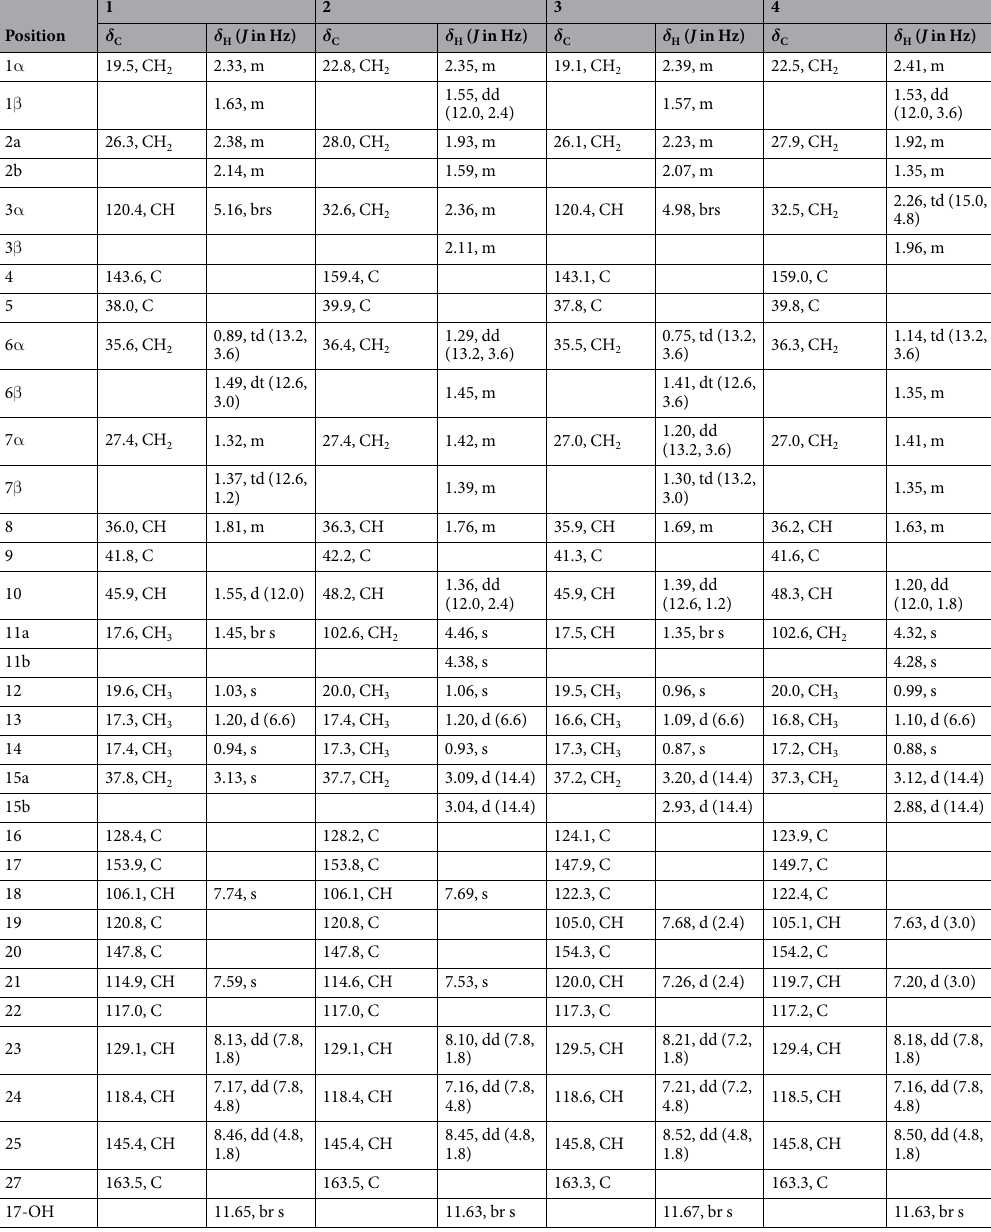
Table 1. 1 H (600 MHz) and 13 C (150 MHz) NMR Data for Dysivillosins A–D ( 1 – 4 ) in Pyr- d 5